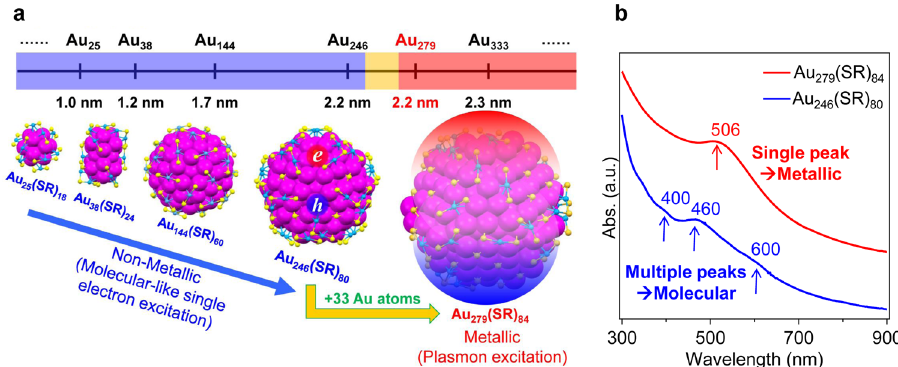
Fig. 2 The size dependence of the electronic and optical properties in atomically precise gold nanoparticles. a Sharp transition from nonmetallic Au 246 (bandgap E g > 0) to metallic Au 279 ( E g = 0). b Manifestation of the nonmetal-to-metal transition in optical